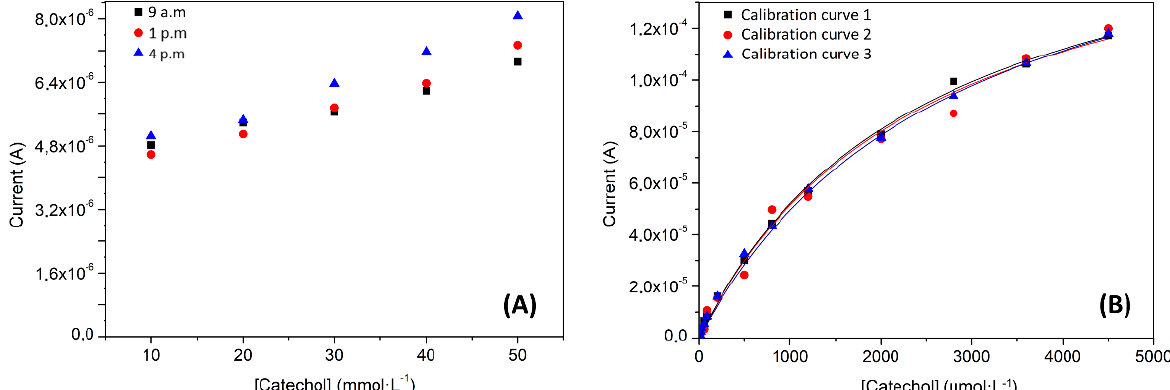
Figure 8. Study of the Lac-RGO analytical biosensor properties, ( A ) calibration curves repeatability test; measurements carried out in three-time instants and without regeneration of the electrode, ( B ) intermediate precision test made with 3 calibration curves on 3 different days with renewed electrode surface.